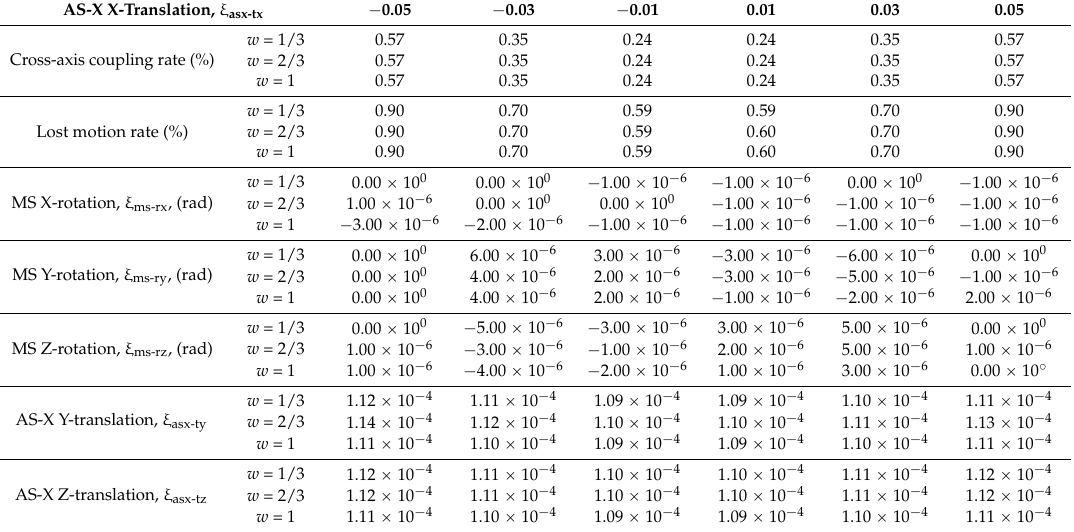
Table 3. The variation of the motion characteristics of the XYZ CPM with the rigid-cube width w. AS-X X-Translation, ξ asx-tx ´